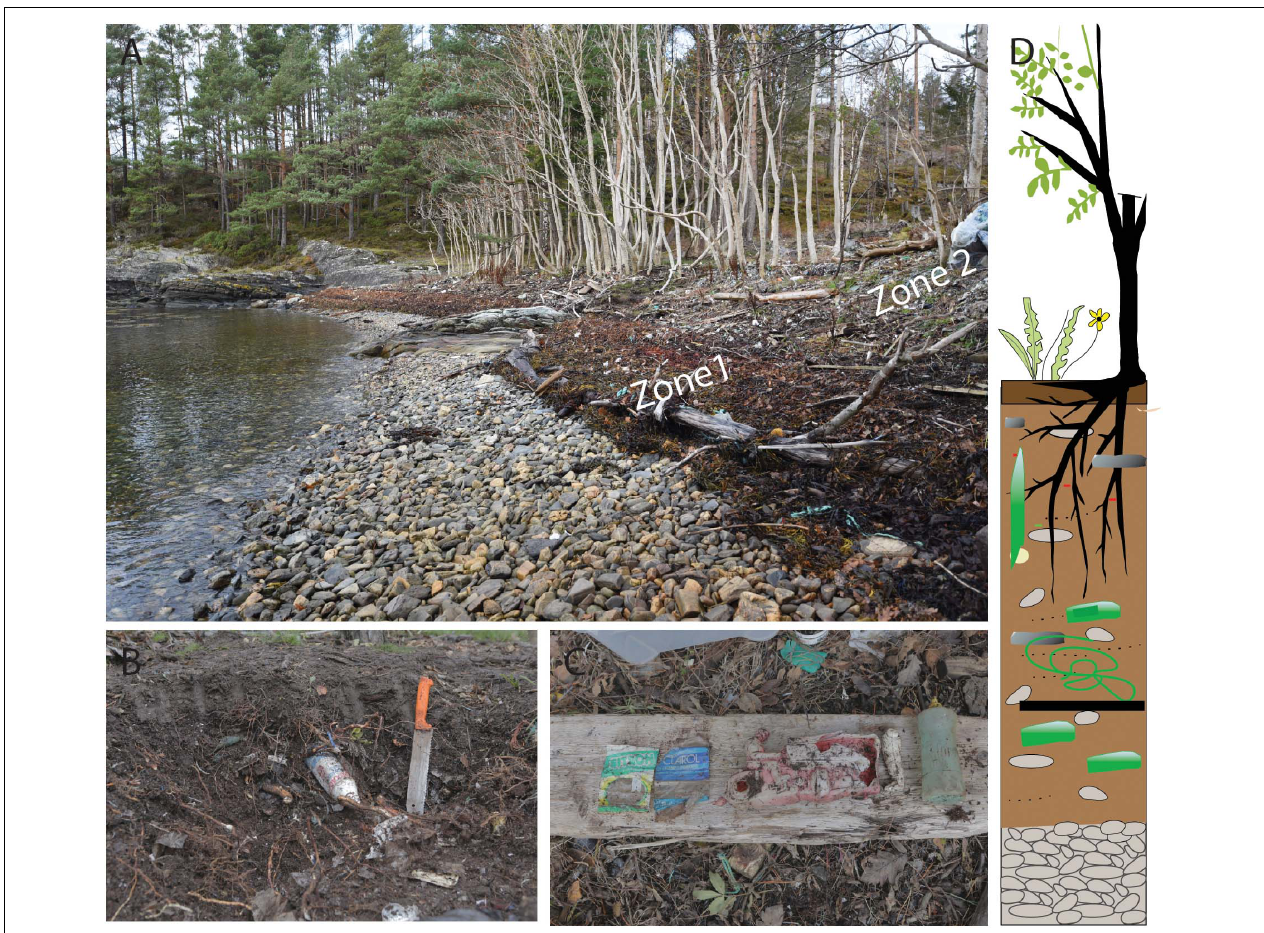
FIGURE 9 | (A) Field photo of pebble beach and Zone 1 and Zone 2 deposits at Kolavika location. (B) profile section (sample KV 2), (C) typical well-preserved items found in the storm embankment (Zone 2), (D) Sketch displaying the soil in Zone 2 with an ash tree growing in the plastic polluted